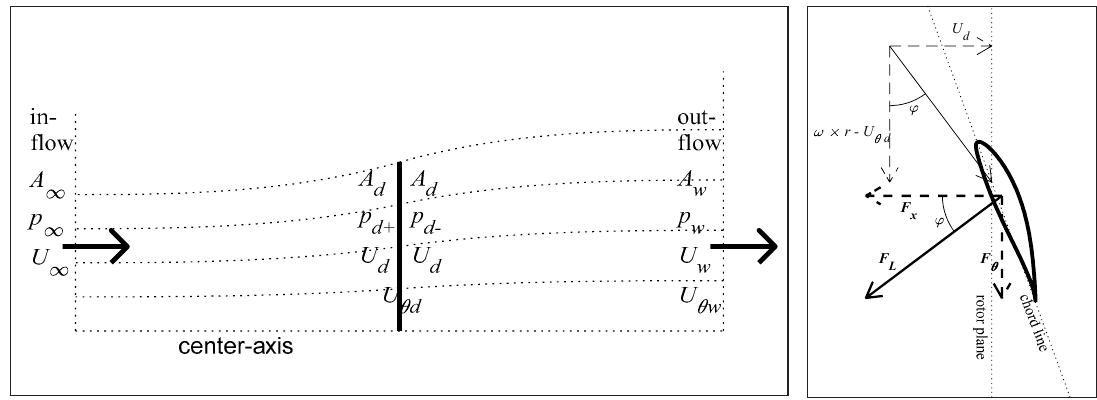
Figure 2. ( Left ): Cross-section schematic of domain, flow quantities, and streamlines. The flow enters the control volume at the far upstream inlet, passes the disk, and exits the control volume at the far downstream outlet. Four annular elements bounded by five stream tubes (incl. the center-axis) are shown. ( Right ): Schematic of forces from rotor blade on flow.